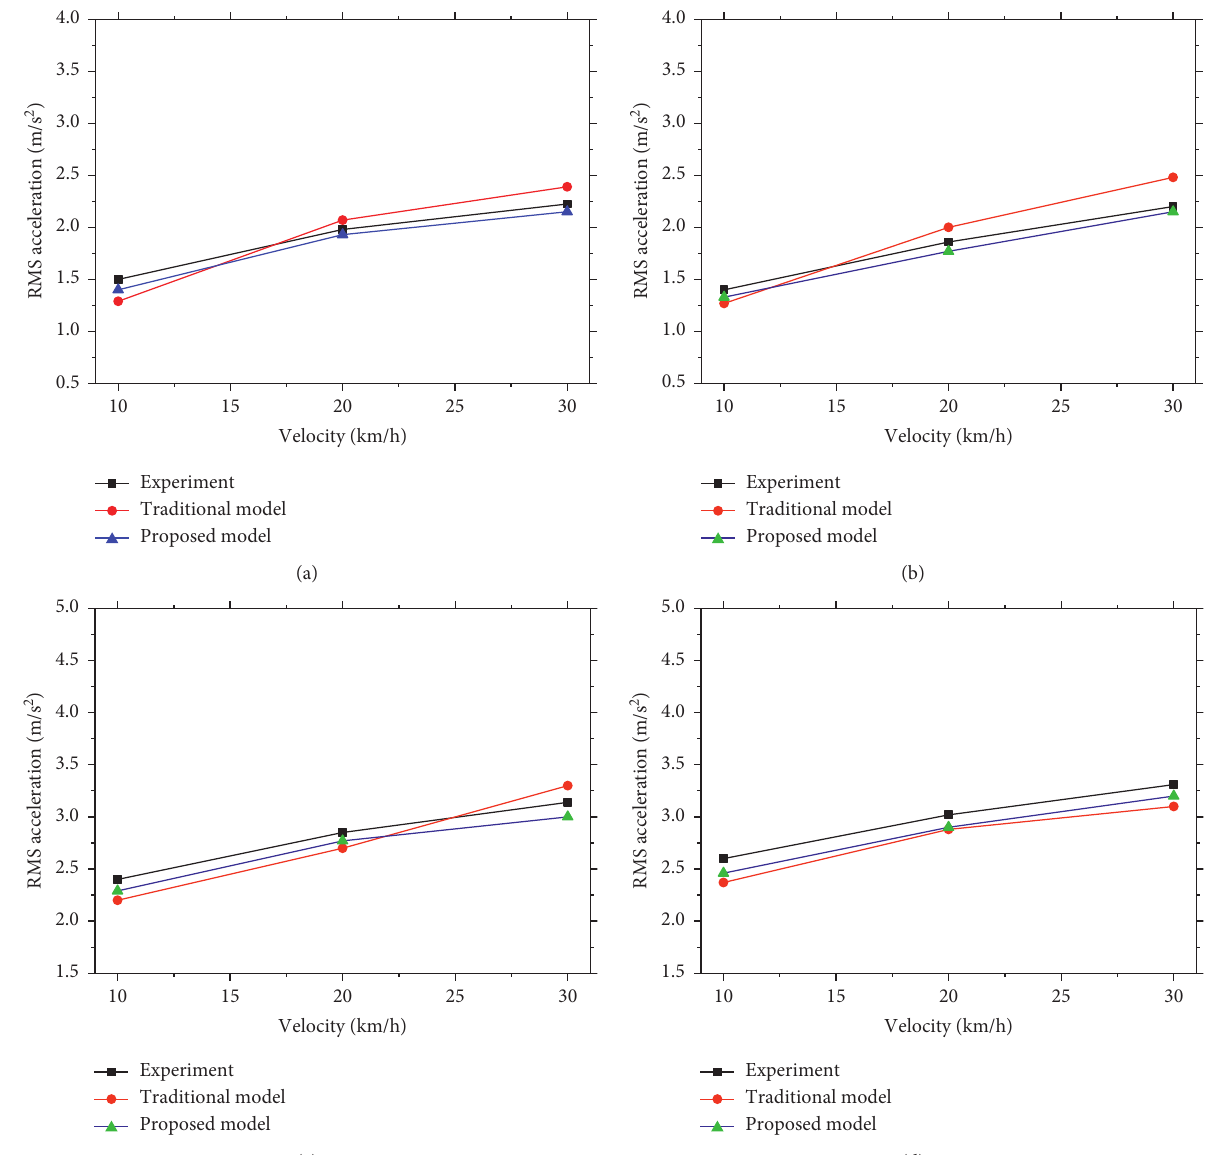
Figure 21: Plots of RMS acceleration versus vehicle velocity for the four suspensions. Comparison between the experimental, traditional models, and proposed model results concerning the upper point of the (a) front left suspension; (b) front right suspension; (c) rear left suspension; and (d) rear right